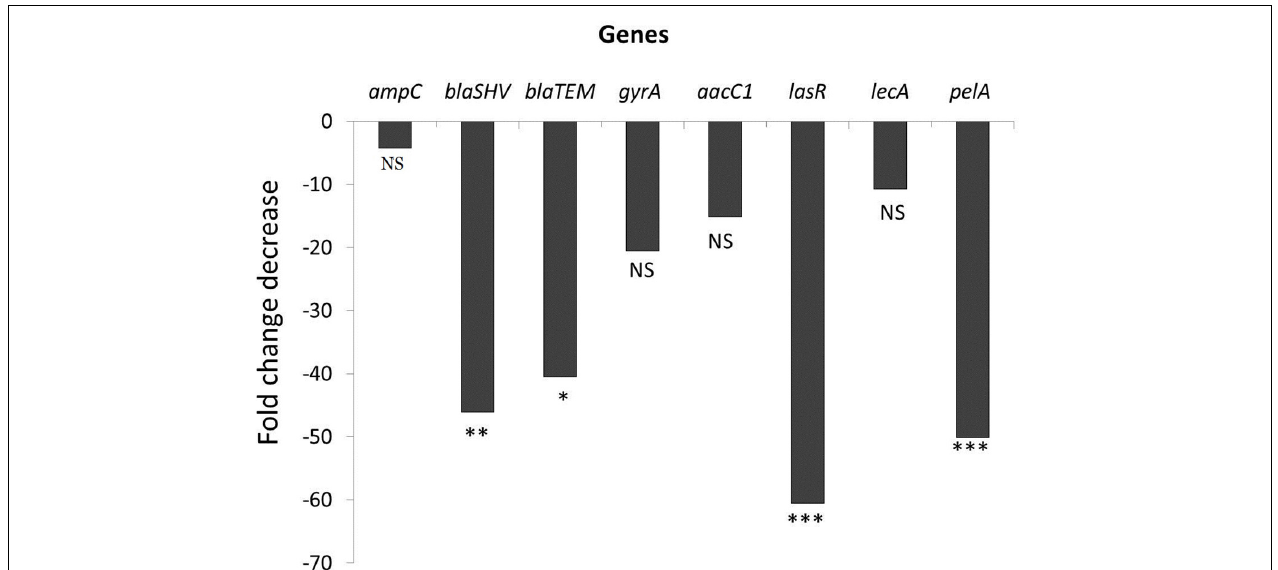
FIGURE 3 | Effect of ascorbic acid on gene expression (* means significant, p - value* < 0.05, value** < 0.01, *** < 0.001).